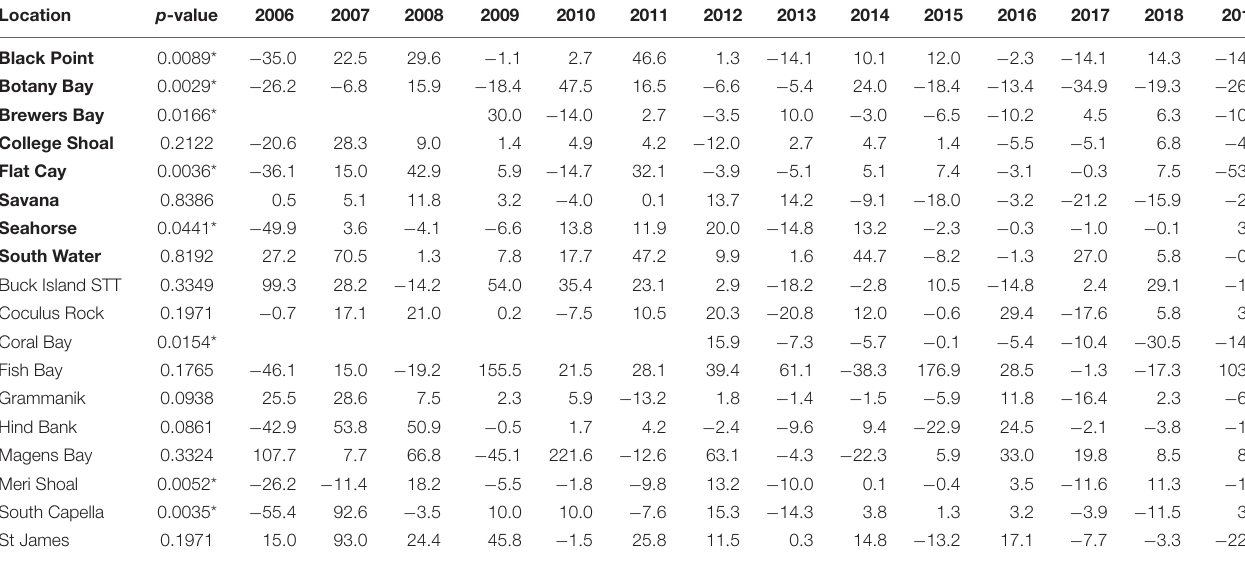
TABLE 4 | Average relative change in coral cover at northern USVI TCRMP locations from 2005 to 2019. Location p